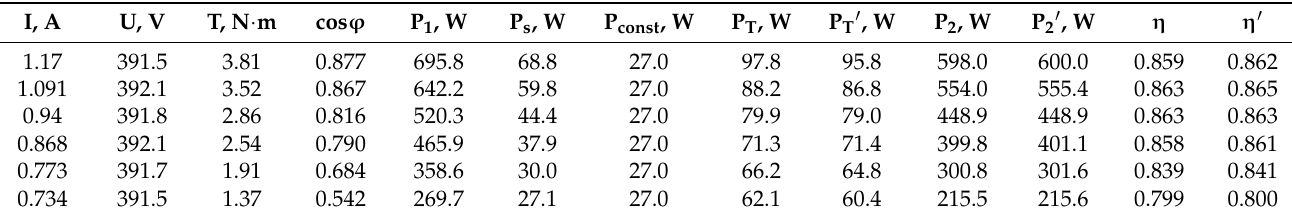
Table 2. Results of the load test and separation of the individual losses.